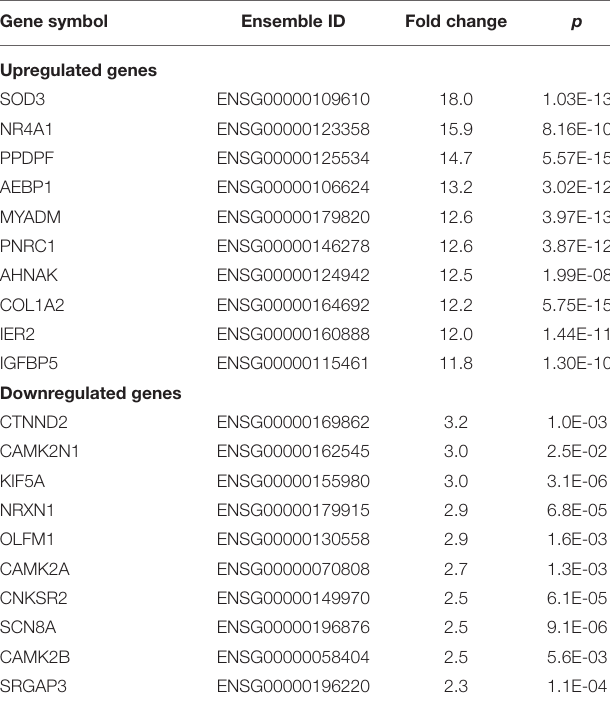
TABLE 2 | Top 10 upregulated or downregulated sex-specific differentially expressed genes (DEGs) in middle cerebral artery (MCA) samples in men patients with Moyamoya disease (MMD).